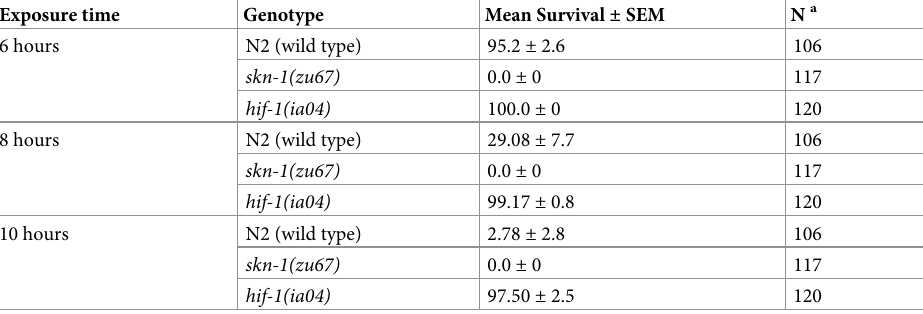
Table 3. Relative requirements for skn-1 and hif-1 : Survival on